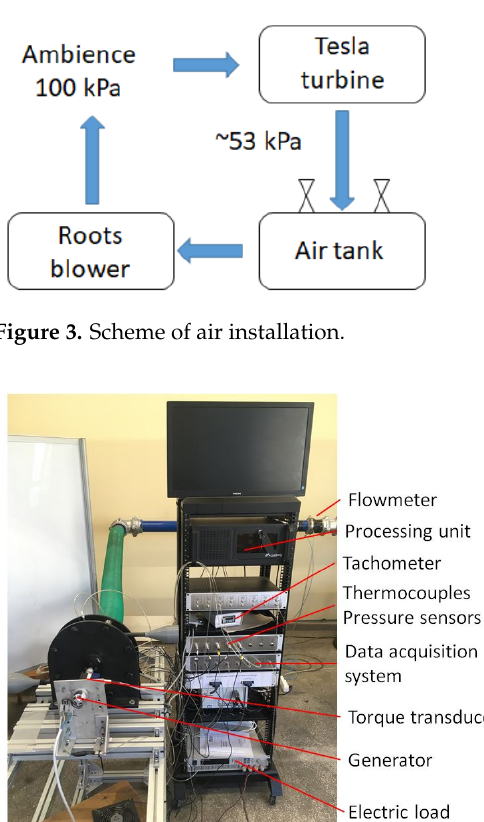
Figure 4. Scheme of measurement unit.